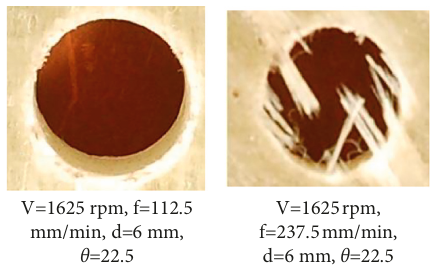
Figure 5: Quality of the holes with varying feed rates.